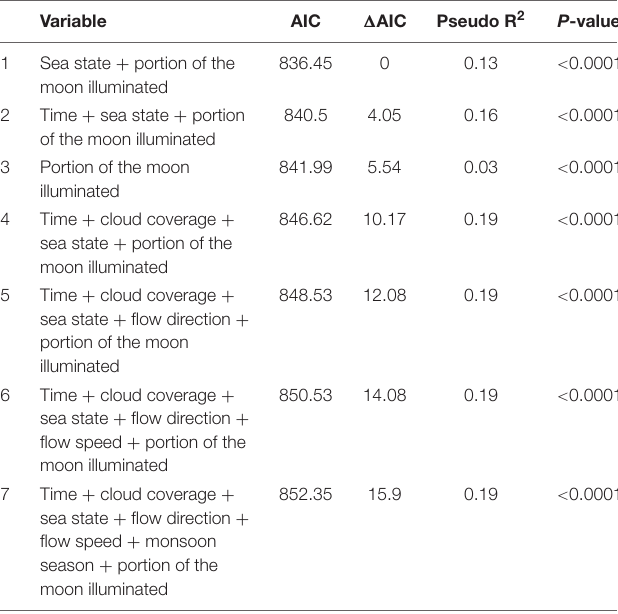
TABLE 3 | Model selection process for Banger-II cleaning